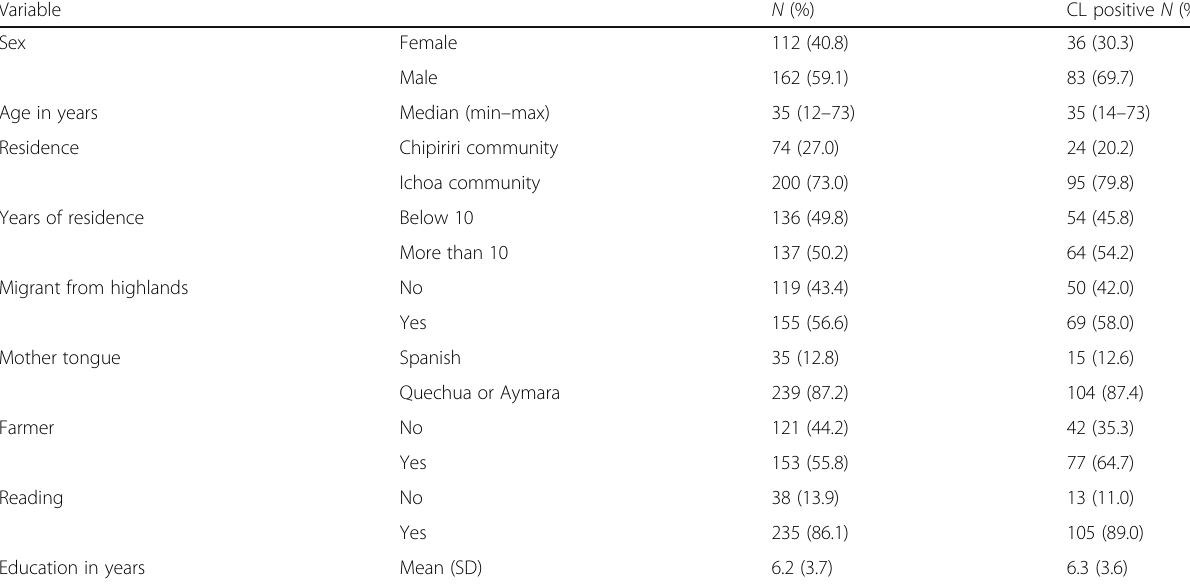
Table 1 Sociodemographic characteristics of the participants expressed in percentages, Villa Tunari 2015